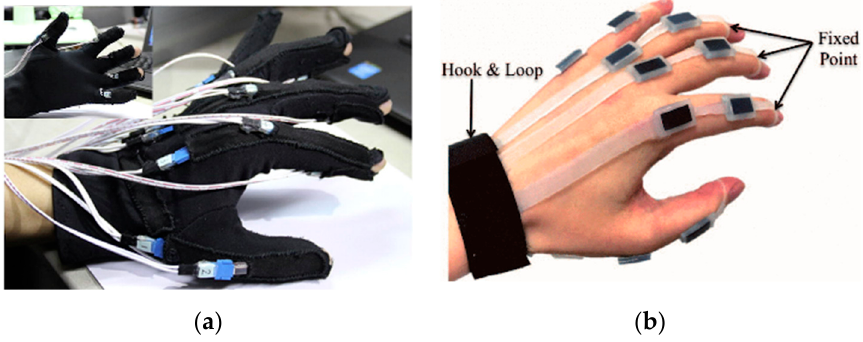
Figure 3. Data gloves based on bend sensors. (a) Data glove from Zheng et al. [28]. ( b ) Soft rubber data-collecting glove [29].